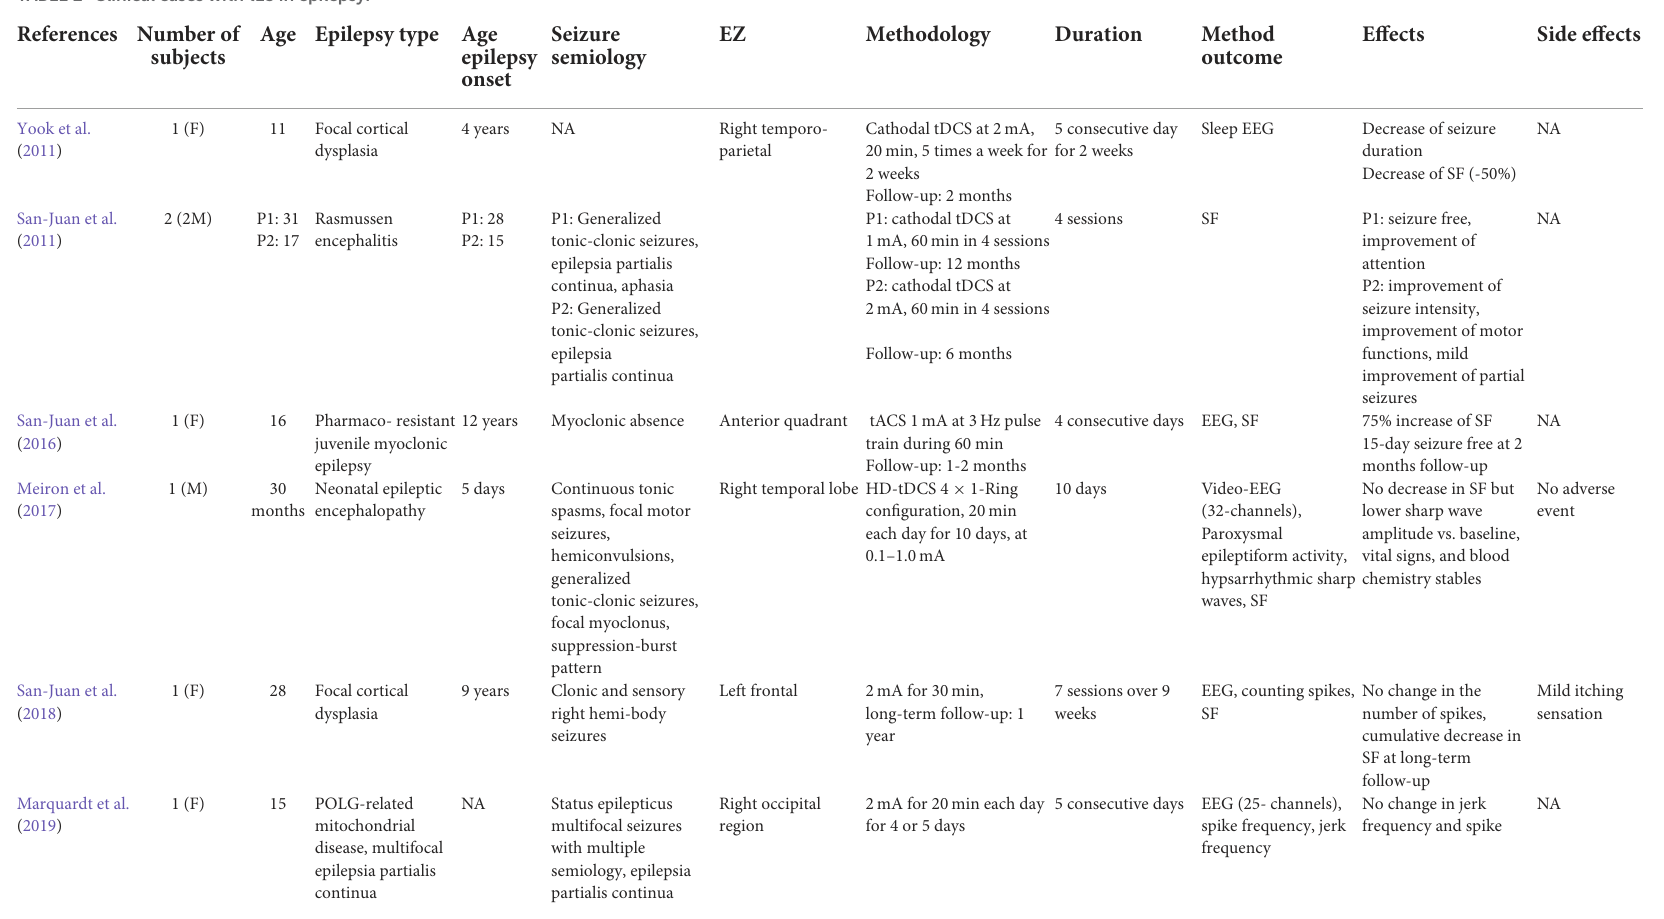
TABLE 2 Clinical cases with tES in